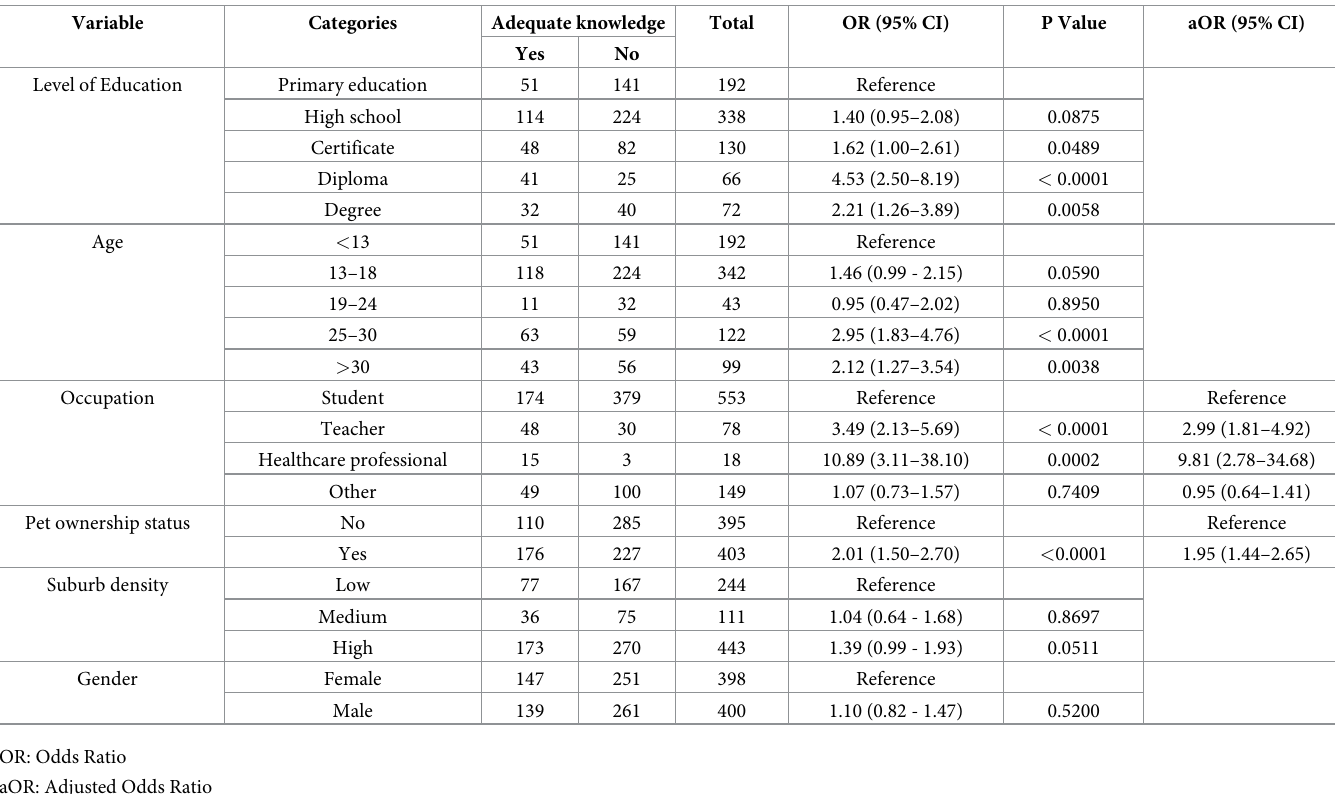
Table 3. Univariate and multivariable logistic regression analysis of the association between the socio-demographic variables and “having adequate knowledge about rabies”.